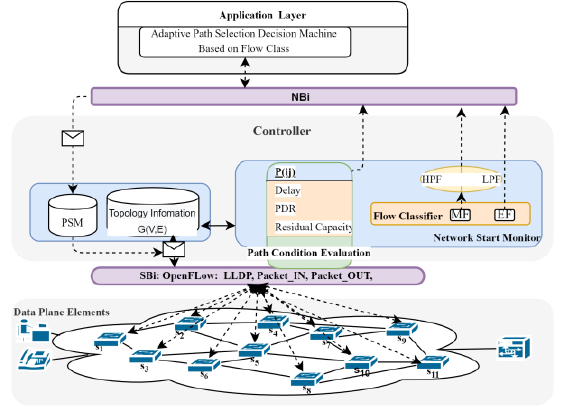
Figure 1. Architecture of APSAF.